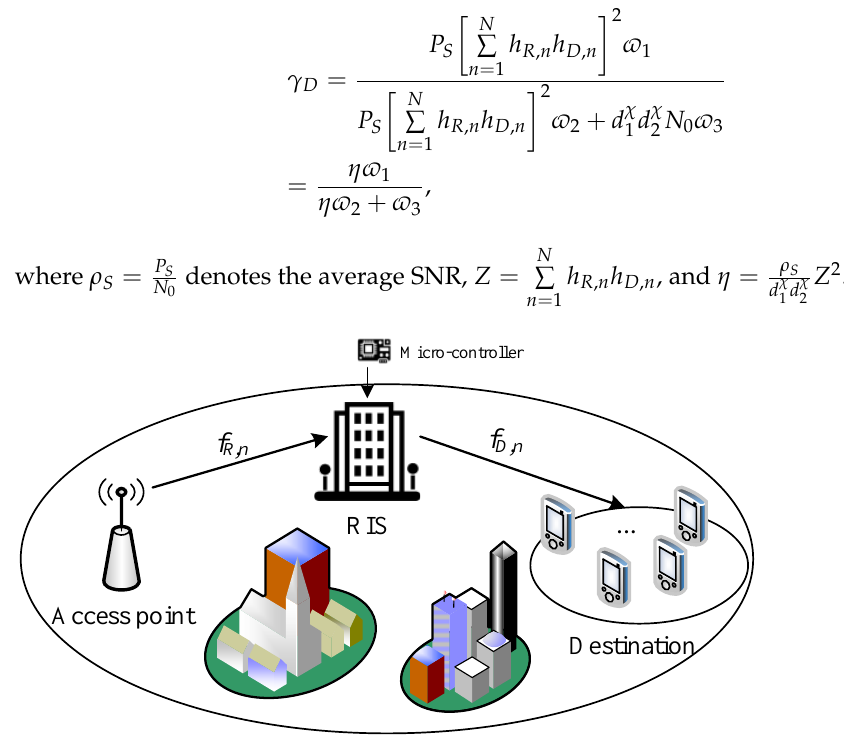
Figure 1. System model for the proposed RIS-aided dual-hop communication